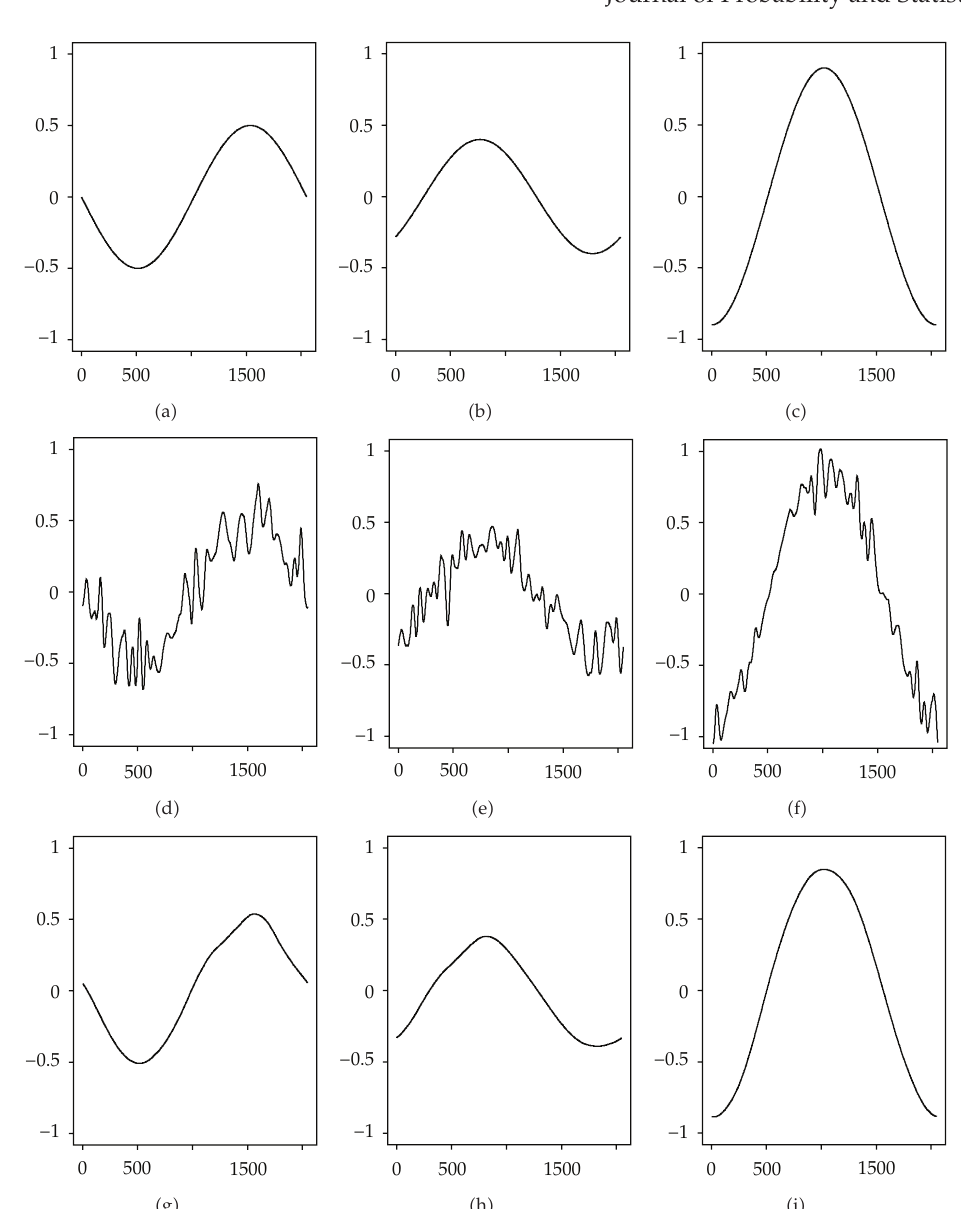
Figure 2: Example 5.1: True parameters and estimates using the Daubechies D12 wavelet: (cid:5) a (cid:6) δ 1 , (cid:5) b (cid:6) δ 2 , (cid:5) c (cid:6) (cid:5) d (cid:6) (cid:7) δ (cid:5) e (cid:6) (cid:7) δ (cid:5) f (cid:6) (cid:7) ω (cid:5) g (cid:6) (cid:5) δ (cid:5) h (cid:6) (cid:5) δ (cid:5) i (cid:6) (cid:5) ω ω 0 , 1 , 2 0 , 1 , 2 0